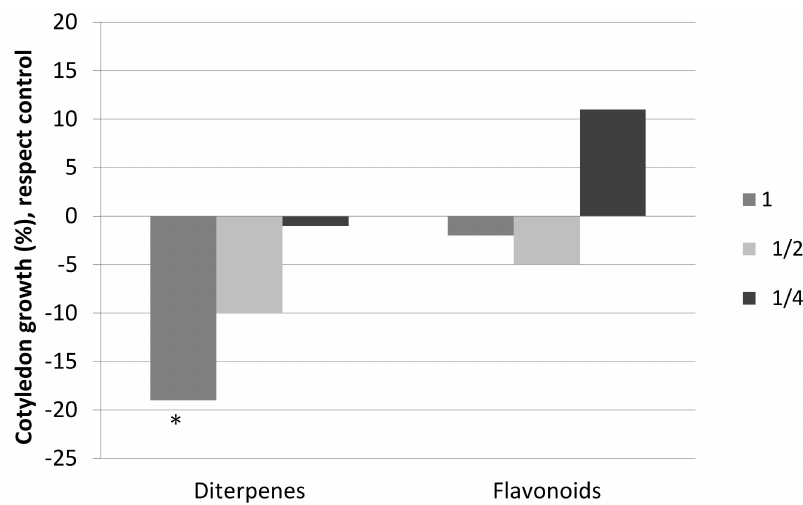
Figure 3. Cotyledon growth, with respect to the control, of the seedlings of C. ladanifer watered with solutions of diterpenes and solutions of flavonoids at three different concentrations: 1 (0.26 g/L), 1 (0.13 g/L), and 1 (0.065 g/L). * Significant difference with respect to the control (M-W; p < 2 4